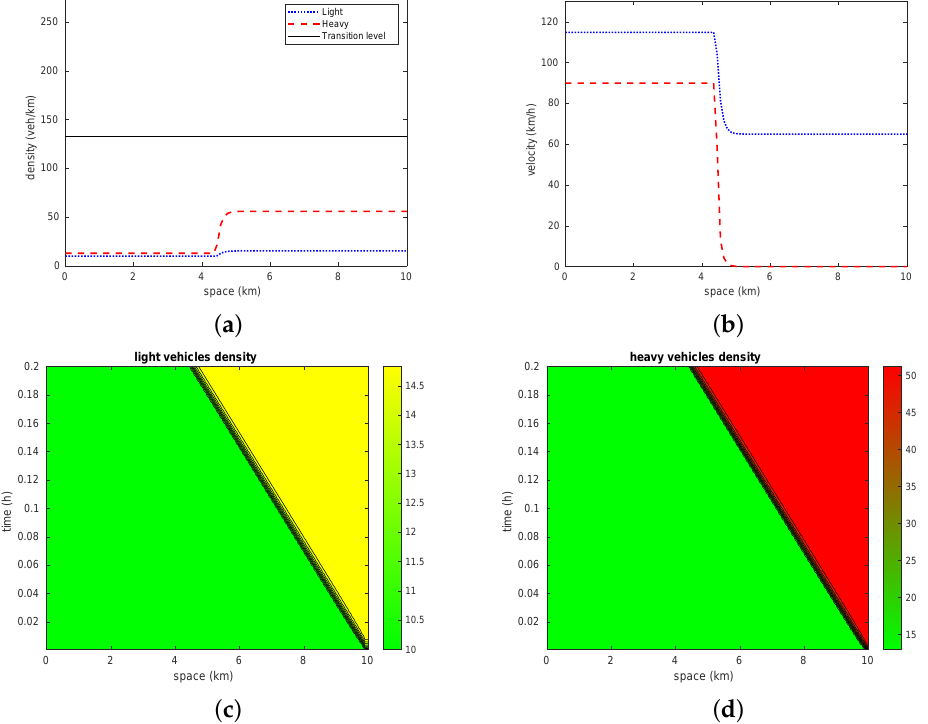
Figure 12. Test 1A: ( a ) Density and ( b ) velocity of light and heavy vehicles as a function of space at final time. ( c ) Density of light and ( d ) heavy vehicles in